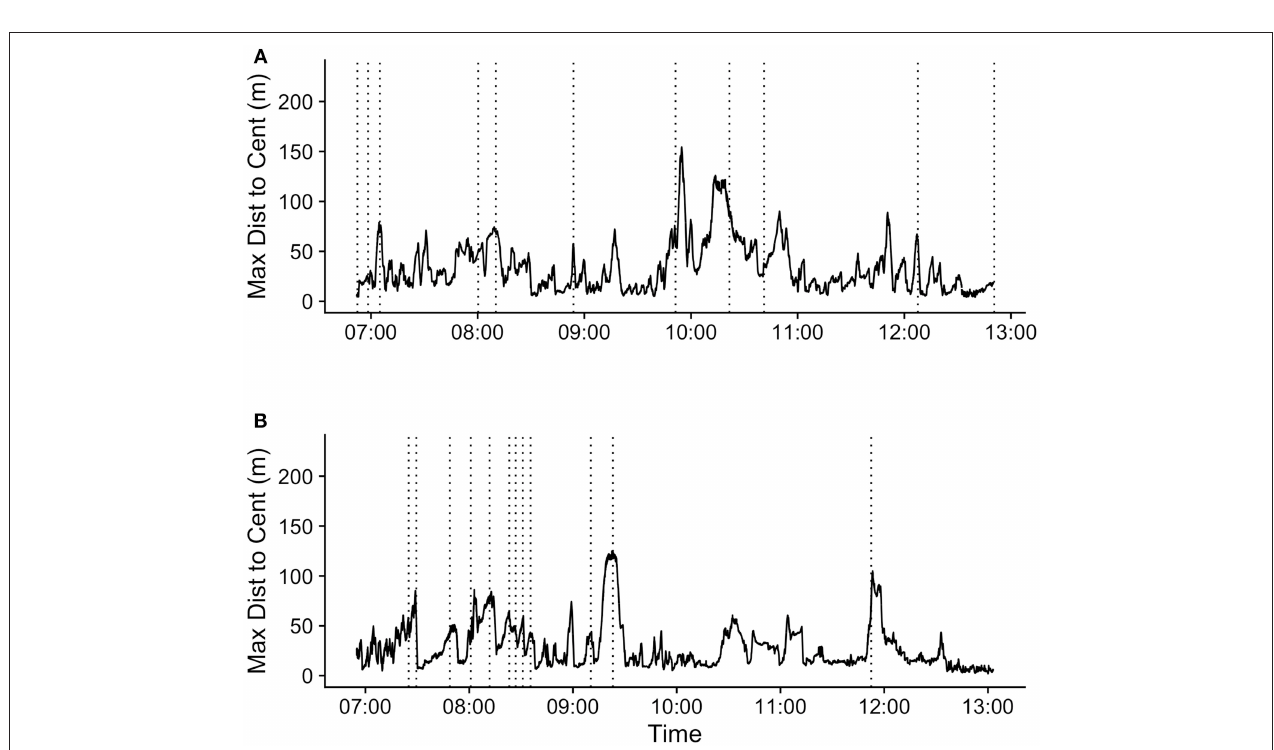
FIGURE 4 | Maximum distance to centroid over time (hh:mm) for 2 days during the study period: (A) 09/10/2018 and (B) 09/15/2018. Vertical dotted lines indicate the times of the first call in each call bout during these periods.